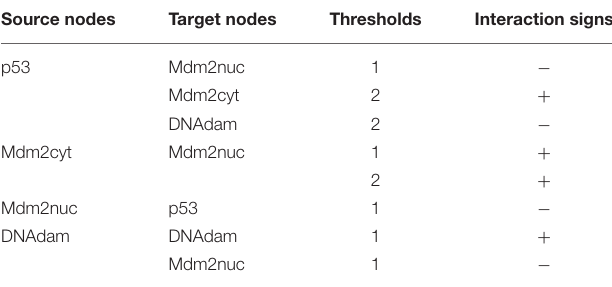
TABLE 2 | Interactions and thresholds for the p53-Mdm2 model.